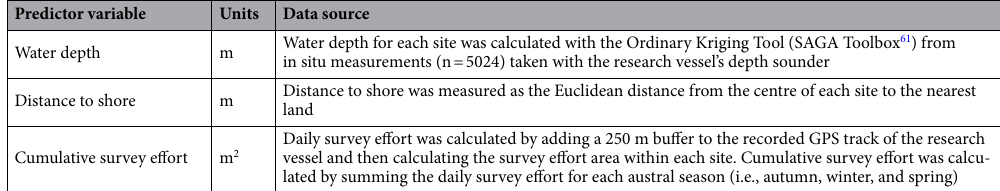
Table 1. The predictor variables included in the joint species distribution model of Australian humpback ( Sousa sahulensis ) and Indo-Pacific bottlenose dolphins ( Tursiops aduncus ) around the North West Cape, Western Australia, and their data sources. Values for predictor variables were calculated within the PyQGIS API using Python 3.8.0 53 and QGIS 3.8.3 Zanzibar 54 .